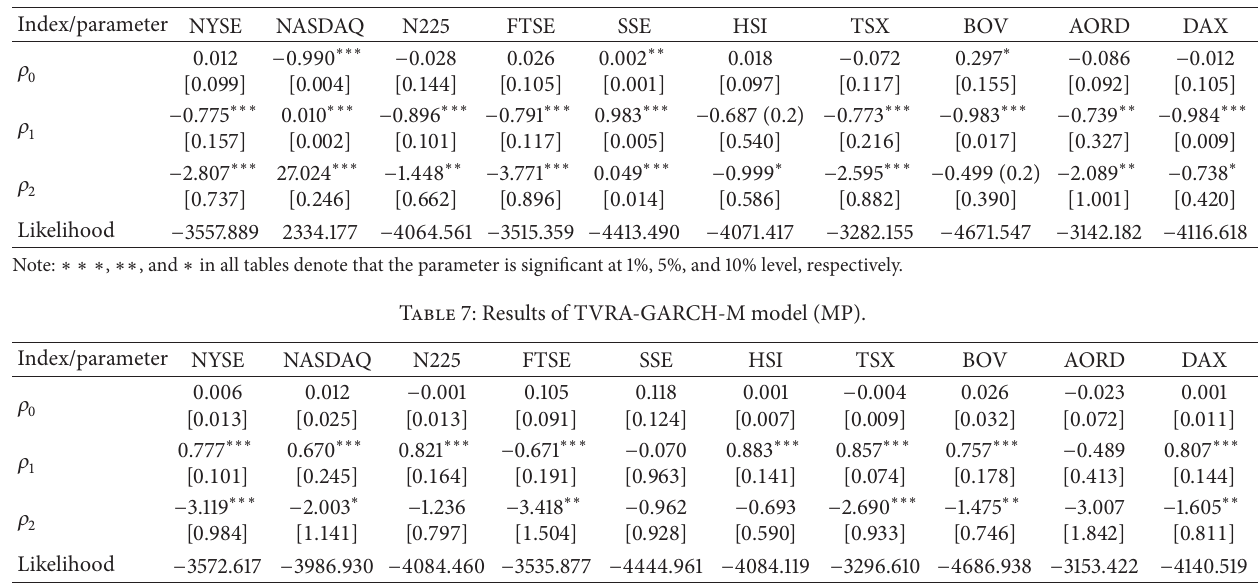
Table 6: Results of TVRA-GARCH-M model ( 𝑃 30 𝑡 ).